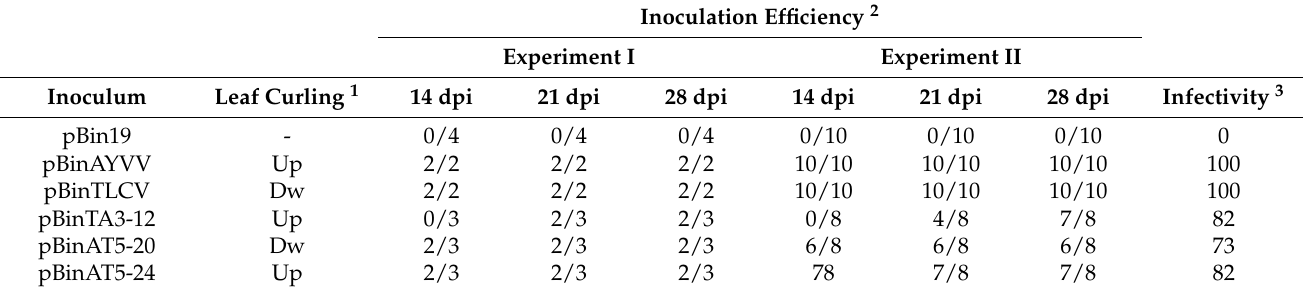
Table 1. Inoculation assay of various infectious constructs of wild-type and chimeric viruses of AYVV and TLCV in N. benthamiana through Agrobacterium -mediated